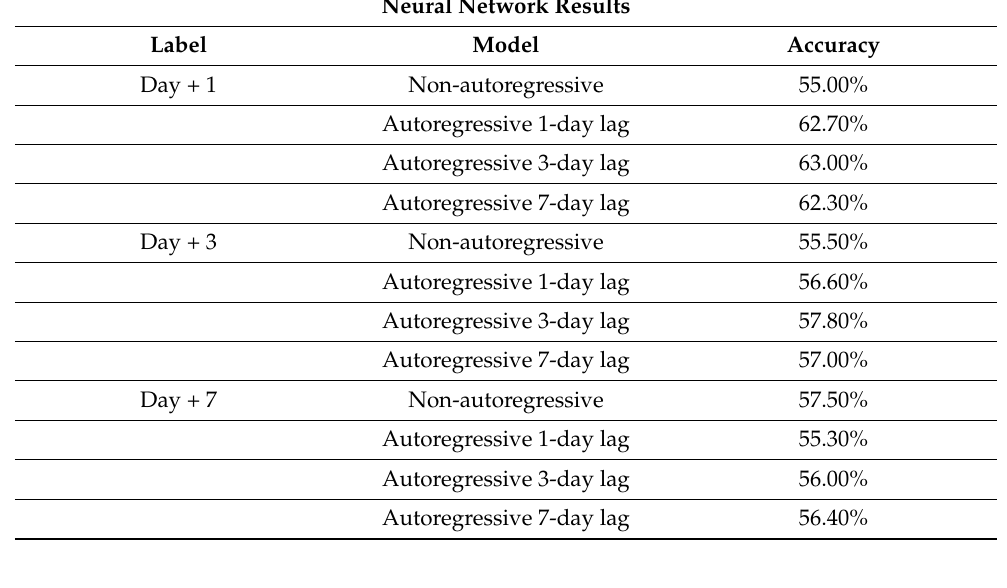
Table 4. Results from Neural Network models.